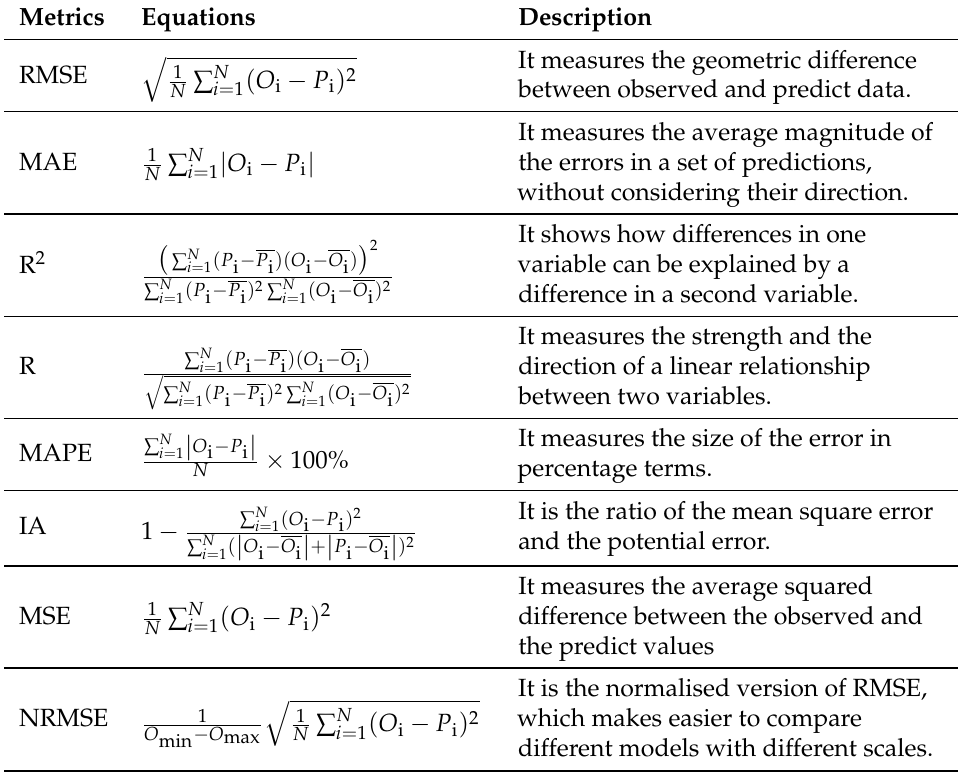
Table 3. The most used metrics (more than six publications) with corresponding equations and definitions (where N is the number of predict days, O i and P i are the observed and predict values, respectively, and O i is the average of observed